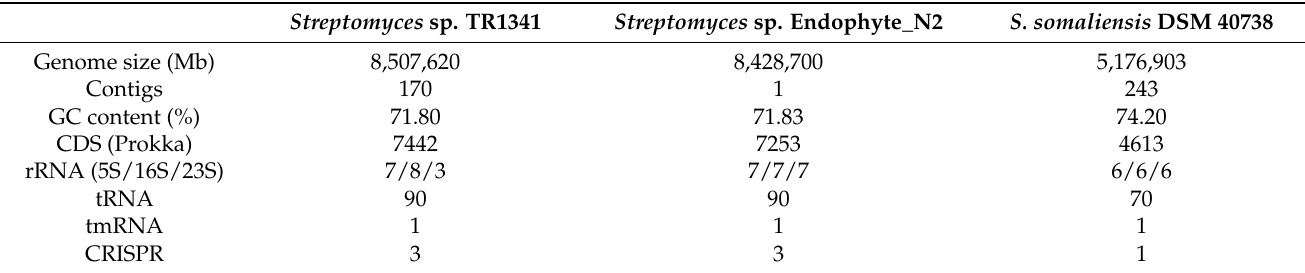
Table 1. Genomic features of Streptomyces sp. TR1341, and comparison with Streptomyces sp. endophyte_N2 and Streptomyces somaliensis DSM 40738.